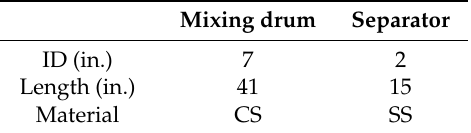
Table 2. Dimensions of the vessels